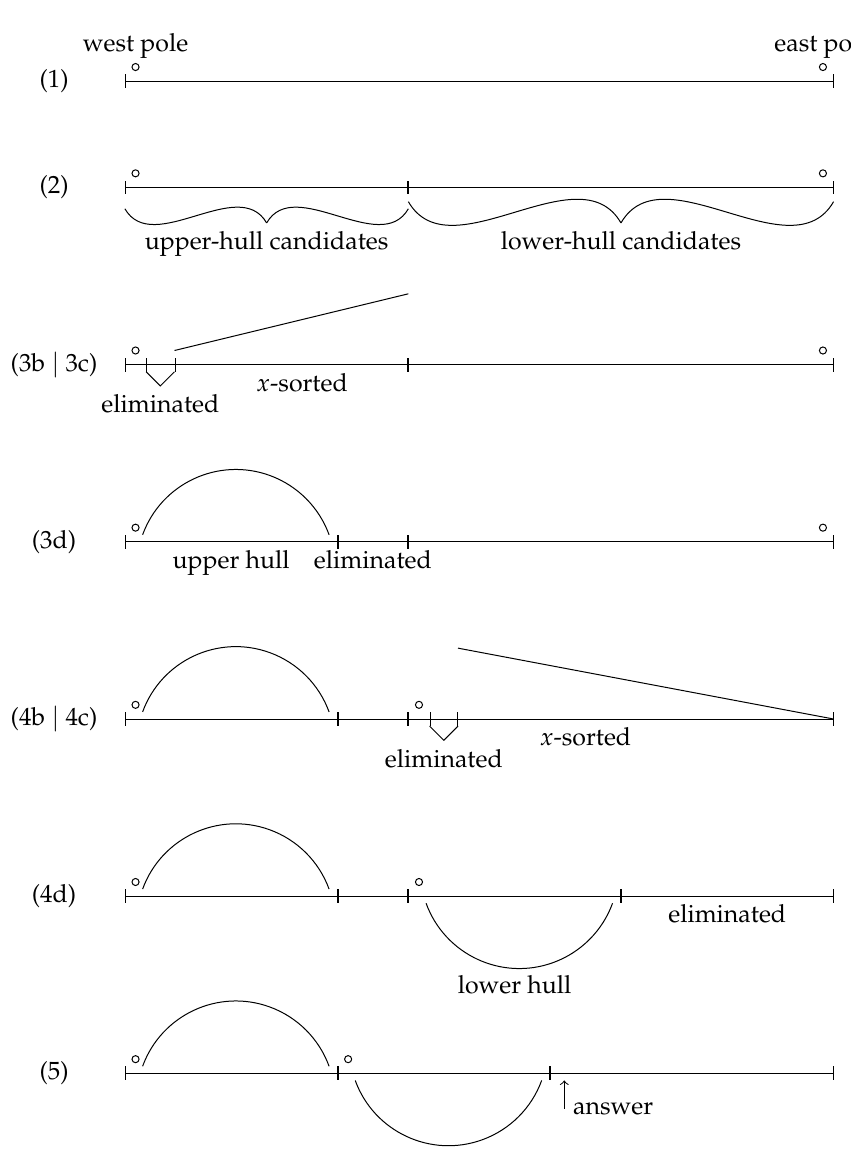
Figure 2. In-place PLANE - SWEEP algorithm